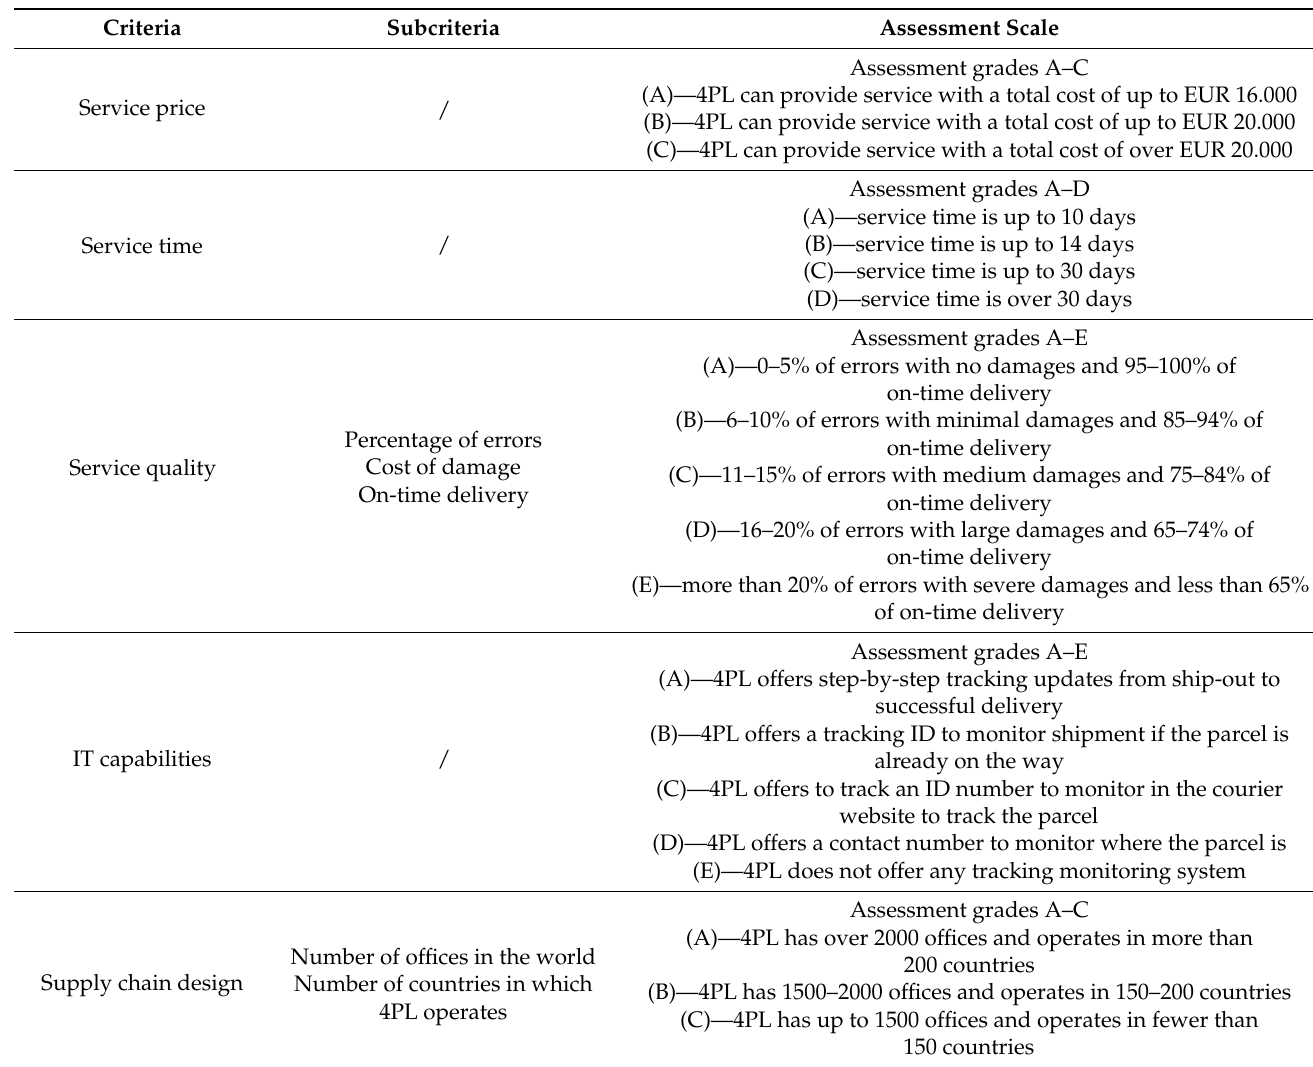
Table 8. Criteria assessment